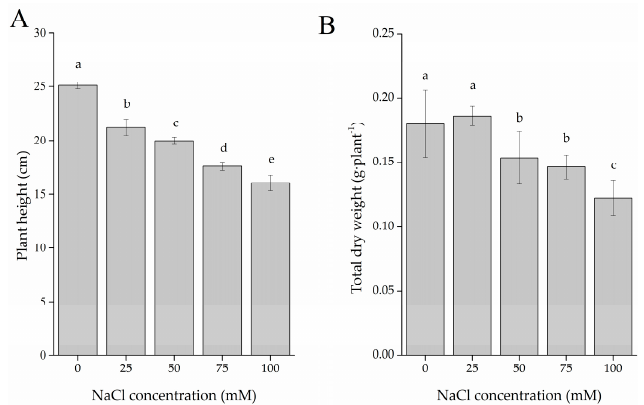
Figure 1. Plant growth of S. tenuifolia influenced by salt stress. ( A ) Plant height and ( B ) total dry weight of plants treated by five different NaCl concentrations. Data are expressed as the mean ± SD. Bars with different letters are significantly different at p < 0.05 ( n = 10).